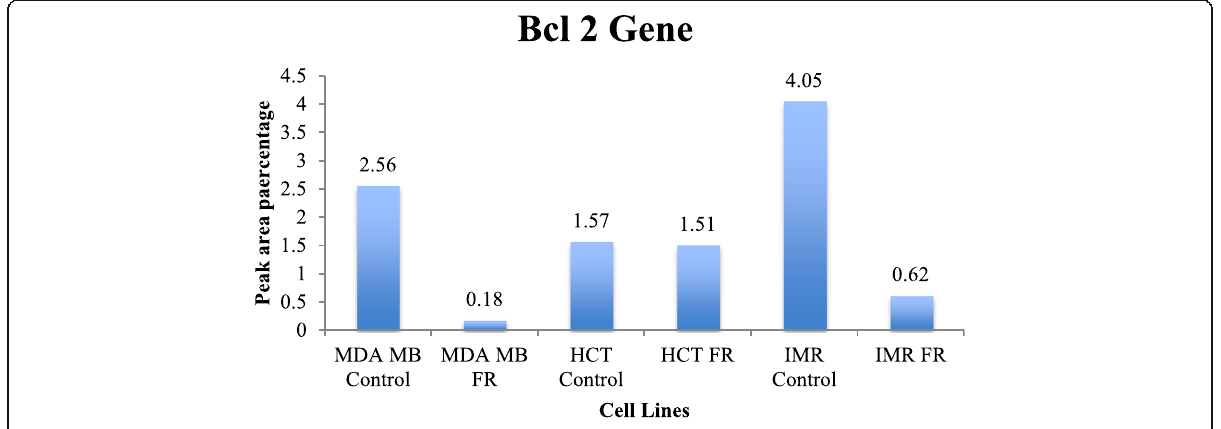
Fig. 13 The relative gene expression of Bcl-2 gene in all the cell lines. FR — Ficus religiosa